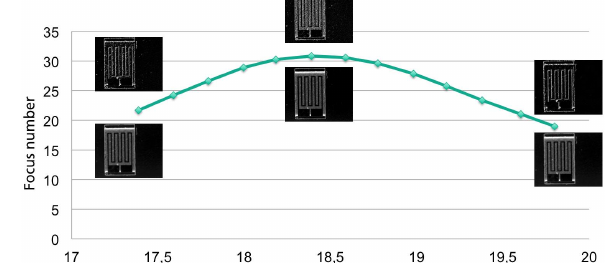
Table 2. Results of focus